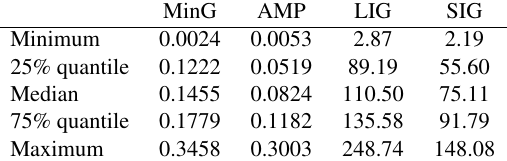
Figure 5: Spatial patterns of 11 years (2000-2011) mean LIG (the annual integral of EVI) in the NATT. Original 0.05 degree resolution result had been aggregated to 0.2 degree resolution for plotting purpose. Table 2: Five-number summary 2 of phenological met- rics in the NATT area. The phenological metrics were the average of 11 years.